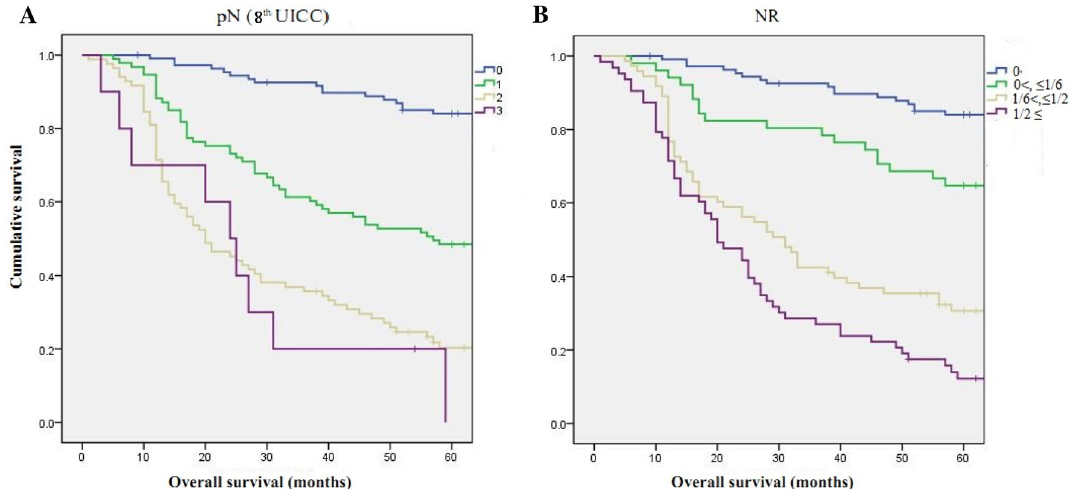
Figure 1. Comparison of survival curves according to the pN and NR stages (both p < 0.001). ( a ) Survival curves of patients with various pN stages. ( b ) Survival curves of patients with various NR stages. NR lymph node metastatic